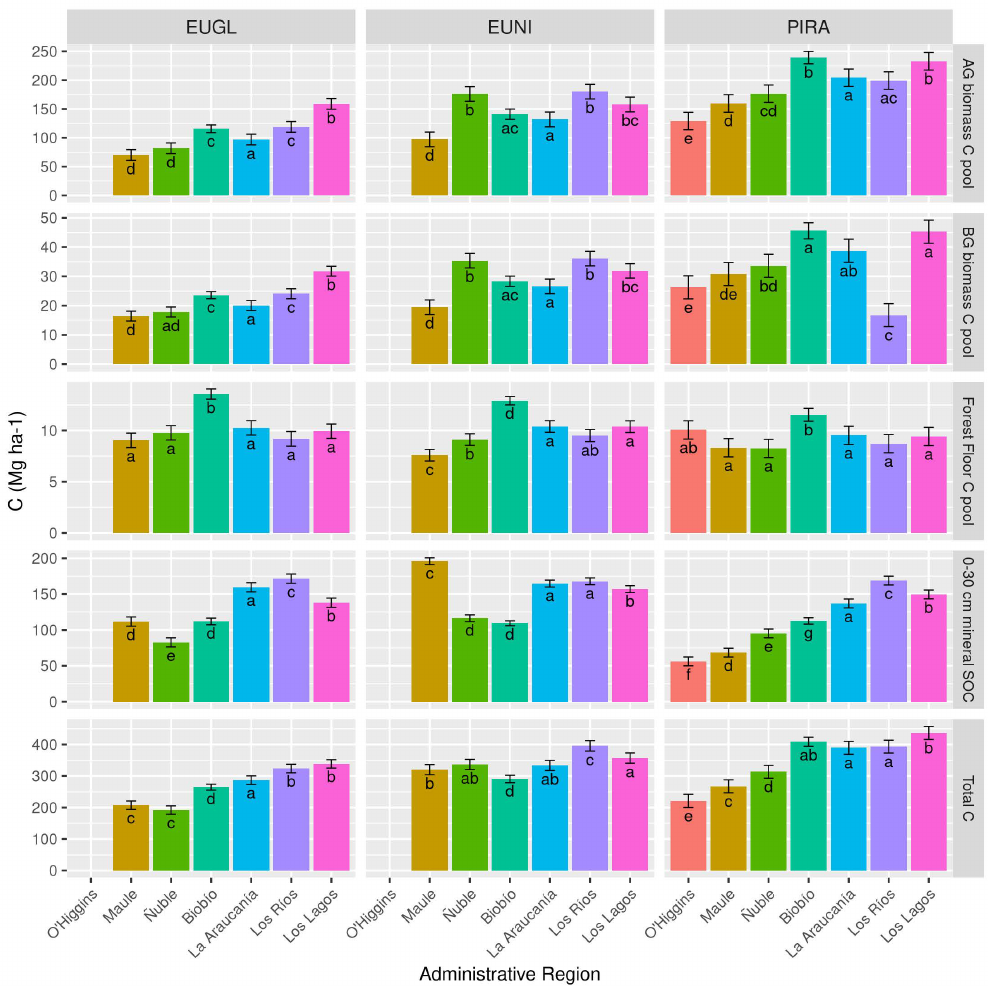
Figure 7. Mean and confidence interval for the 4 carbon pools (Above-ground (AG) biomass, Below-ground (BG) biomass, forest floor and 0–30 mineral soil organic carbon (SOC) C pools) and the total C for Eucalyptus globulus (EUGL), Eucalyptus nitens (EUNI) and Pinus radiata (PIRA) at rotation age (10–14 years-old for EUGL and EUNI, 20–24 years-old for PIRA) at the 7 administrative regions evaluated. Means denoted by a different letter indicate significant differences for p <